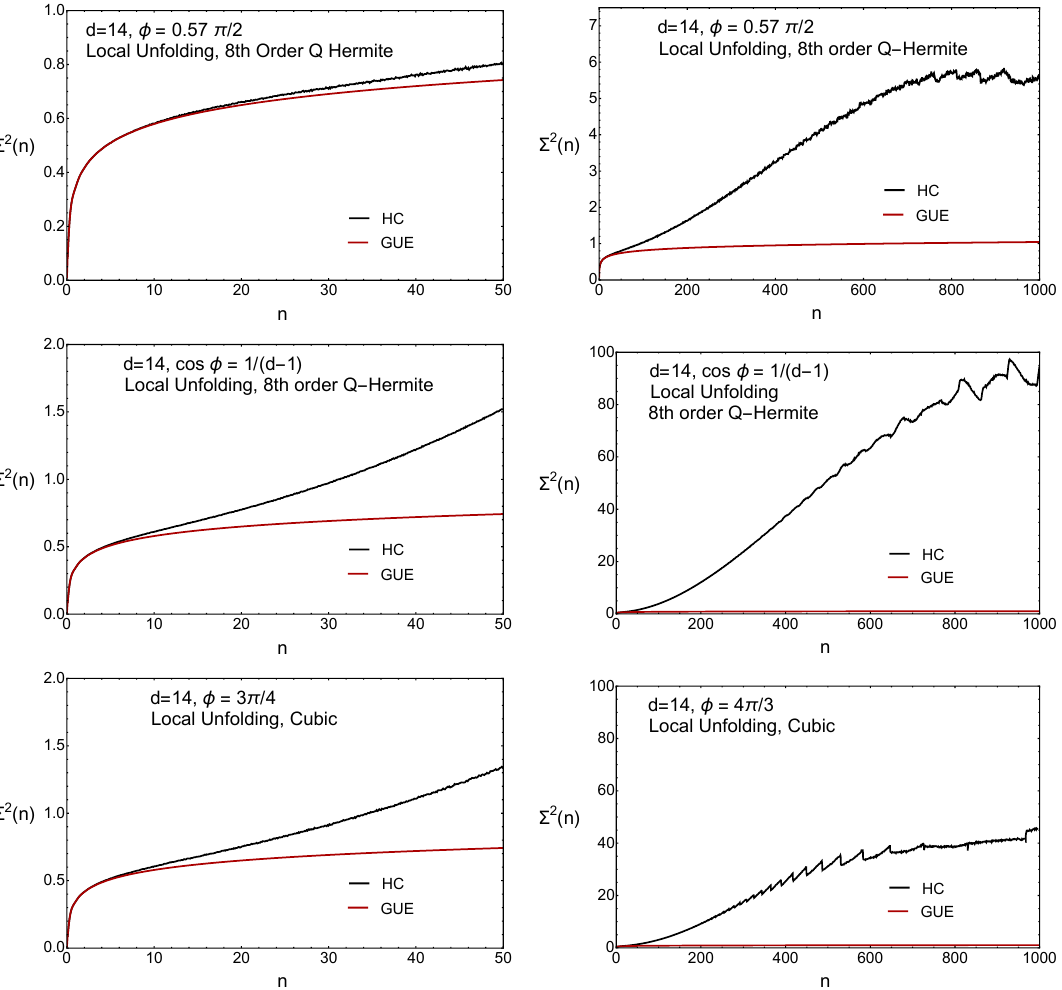
Figure 6 . The number variance Σ 2 ( n ) versus the average number of eigenvalues n in the intervals for d = 14 . The values of the fluxes are indicated in the legends of the figures. The results have been obtained by unfolding the spectral for each realization separately (local unfolding). For φ = 0 . 57 π/ 2 , the curves are indistinguishable from the results for ensemble unfolding. The left figures give the same curves as the right figures but for a smaller range of n